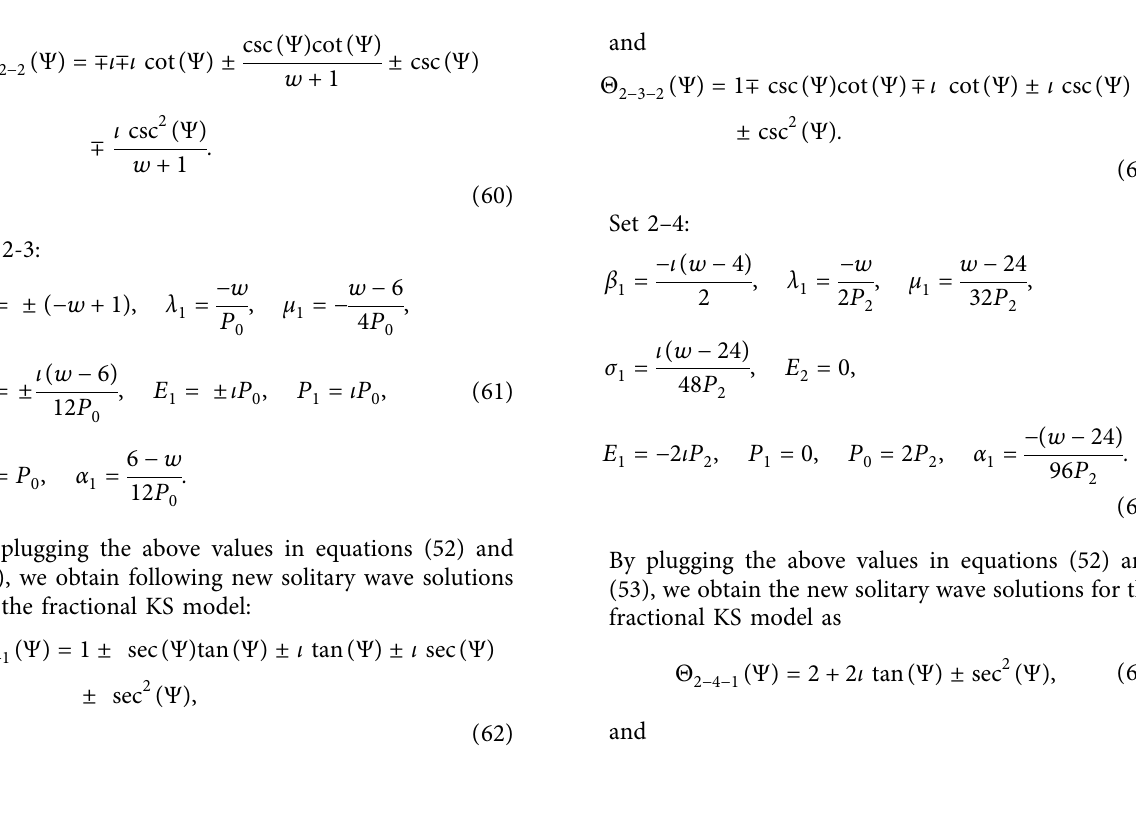
� 0 . 5, and w � 0 . 3. (a) Θ 211 , (b) Θ 212 , (c) Θ 211 , Θ 212 1